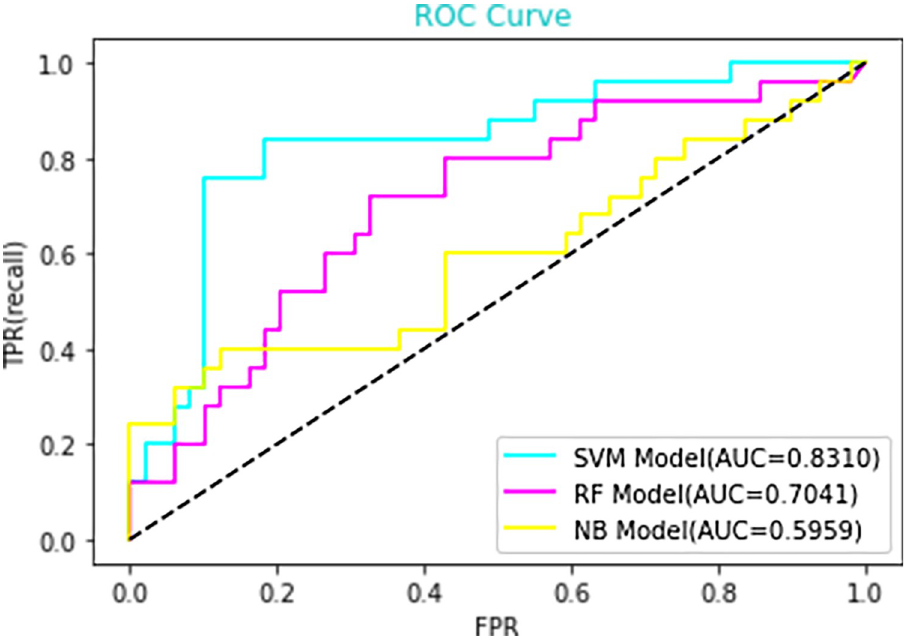
Fig 6. Receiver operating characteristic (ROC) curves of the three candidate models for the prognosis of IgAN without ’Crescent proportion’ and ’Global crescent proportion’.